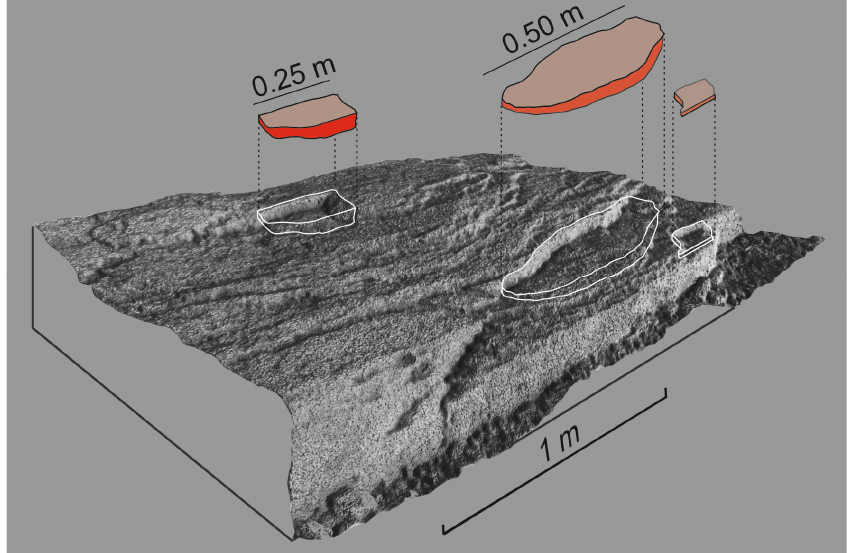
Figure 9. An example of limestone plate erosion was identified from 2019 to 2020 at the Langhammars platform (LP). A mesh model made of TLS point clouds.